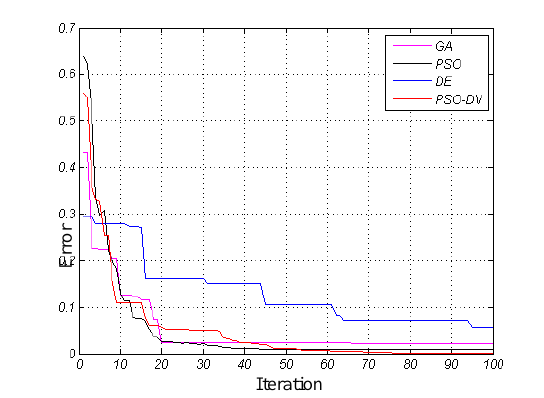
Figure 16. Error rate for GA, PSO, DE and PSO-DV (frame 1).